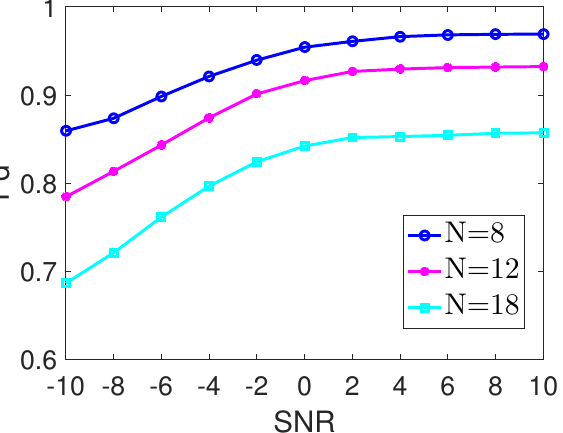
Figure 4. Detection Probabilities of the AdNoR algorithm with different down-sampling factors N = 8,12,18, and with U = 360, N / M = 2, P = 180, D =